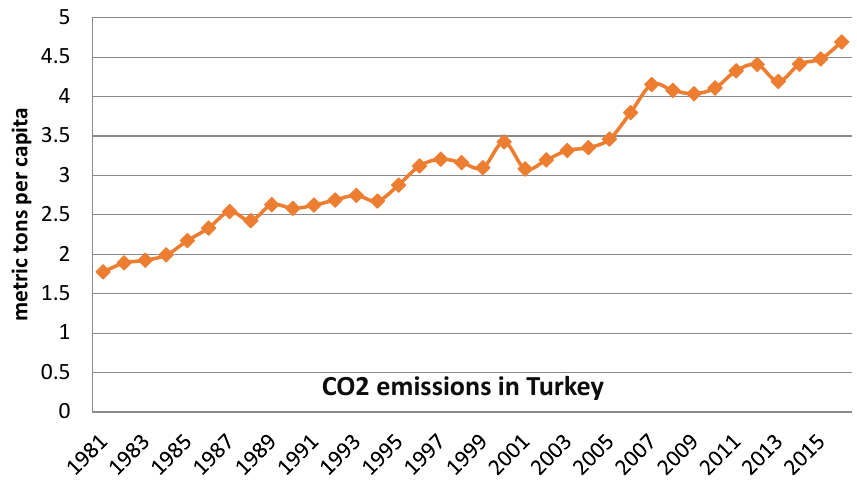
Figure 1. Levels of CO (cid:2870) emissions over the period from 1981 to 2015.